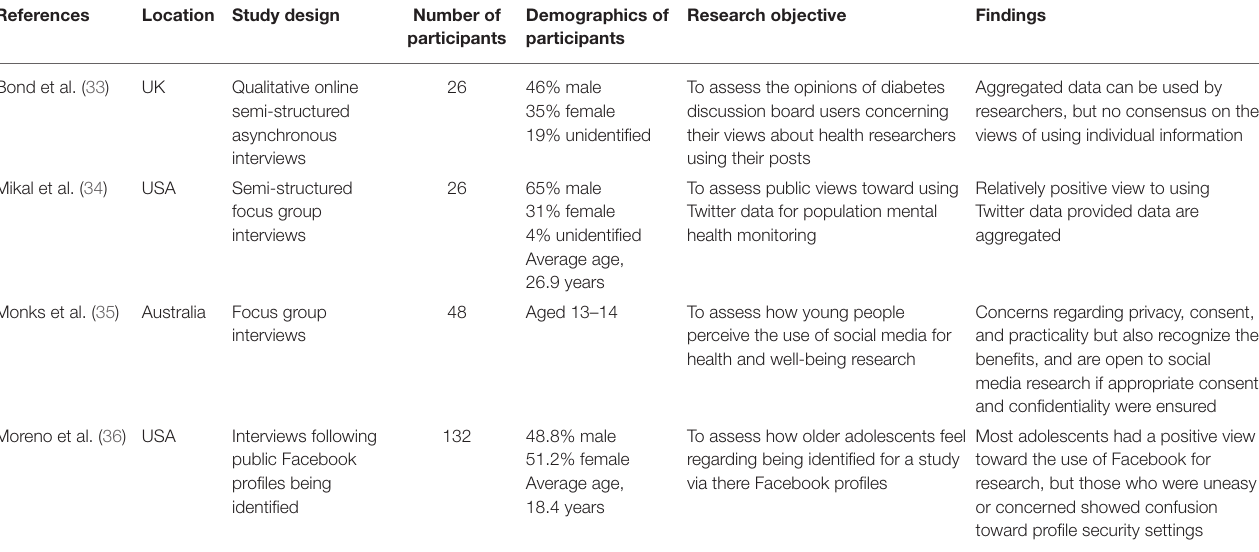
TABLE 3 | Study characteristics for qualitative studies of social media